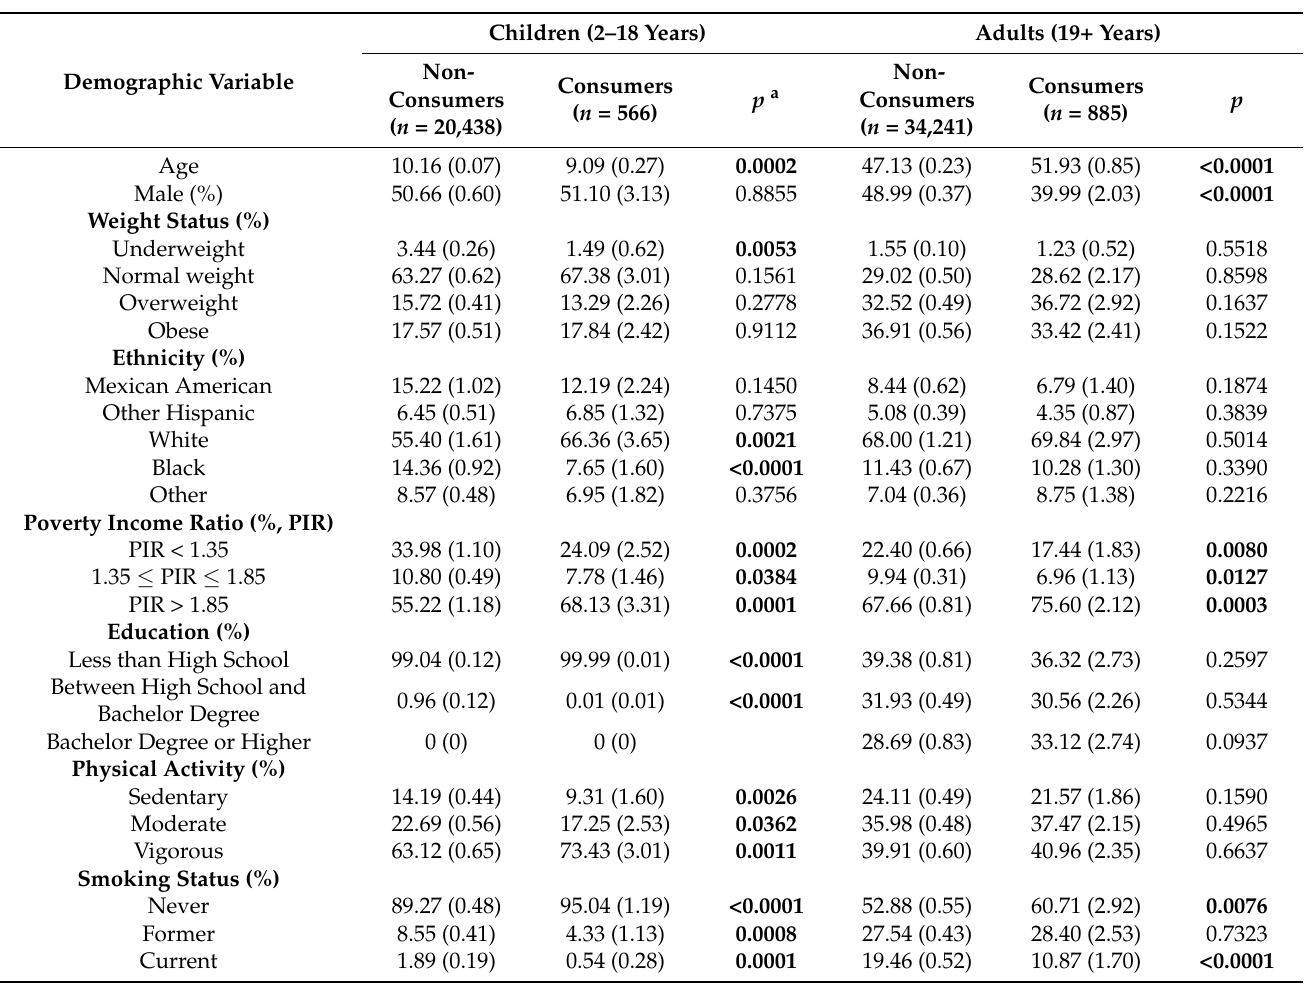
Table 1. Demographic characteristics of children (2–18 years) and adult (19+ years) watermelon consumers and non-consumers, NHANES 2003–2018.